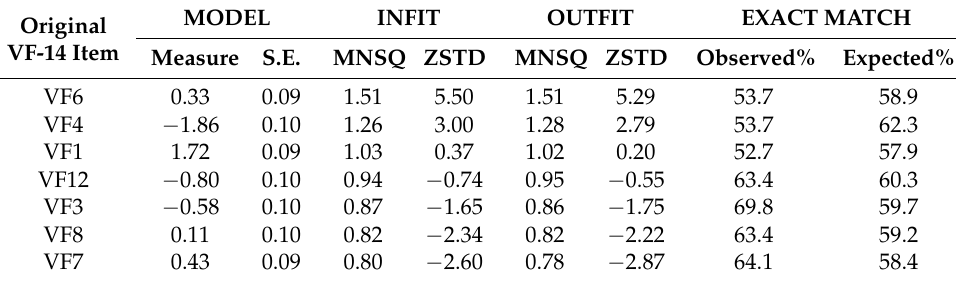
Table 2. Fit statistics for the modified VF-14